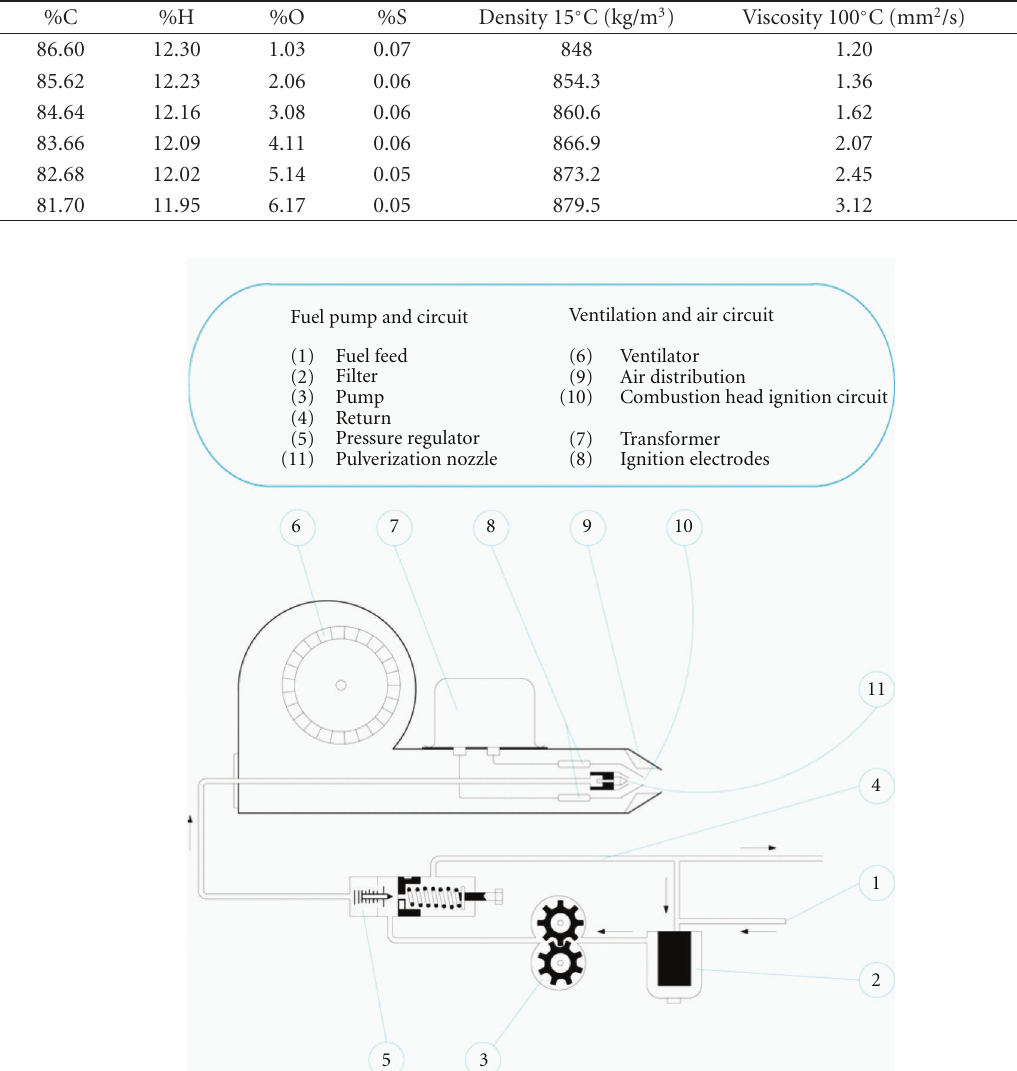
Table 4: Characteristics of the mixtures of diesel and lard.